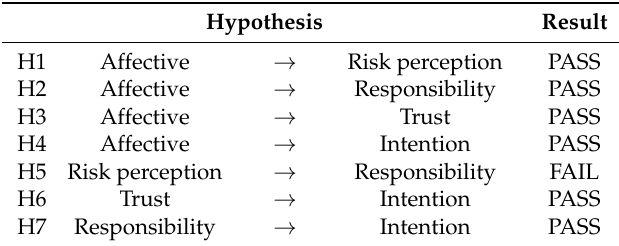
Table 6. The result of the hypotheses.